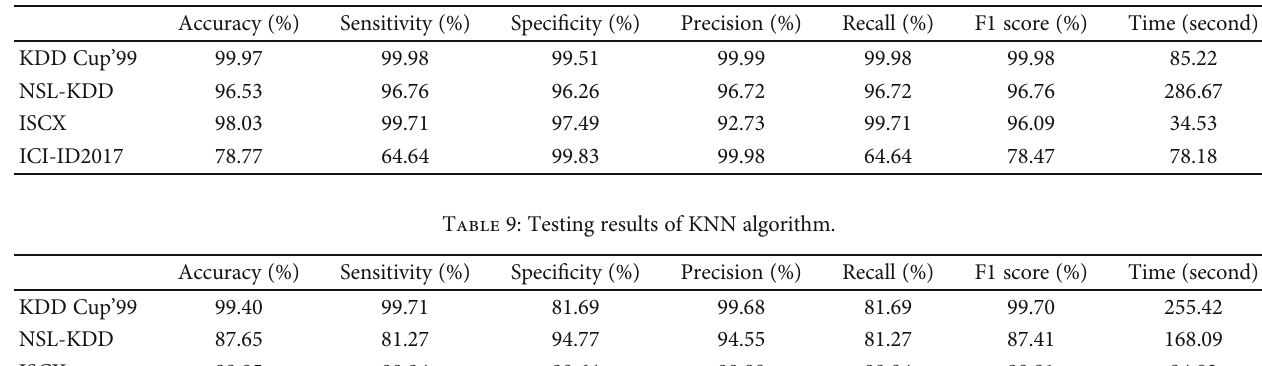
Table 8: Testing results of SVM algorithm.